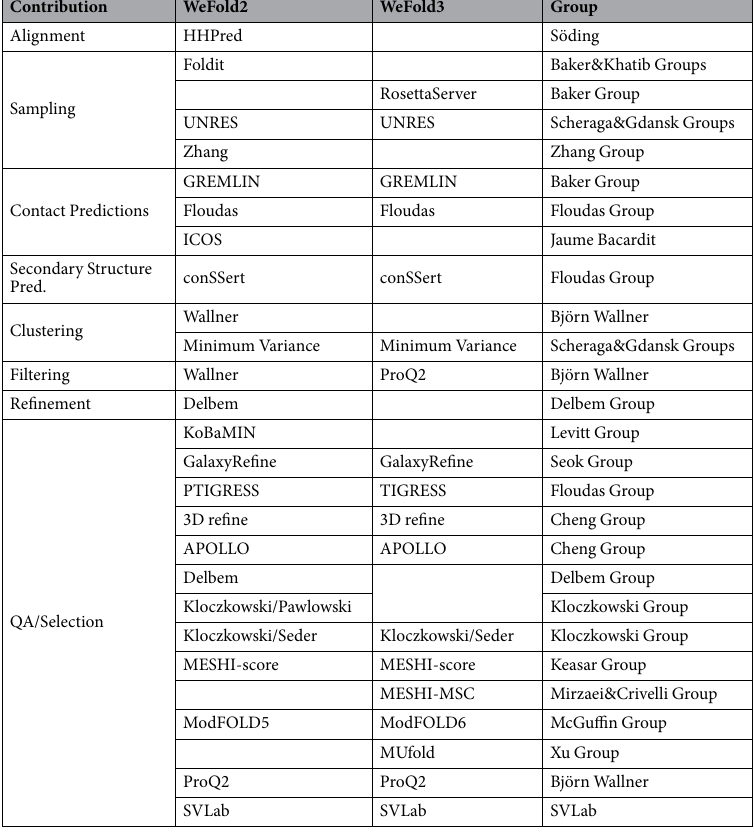
Table 1. Pipeline components in WeFold2 and WeFold3 and the groups that